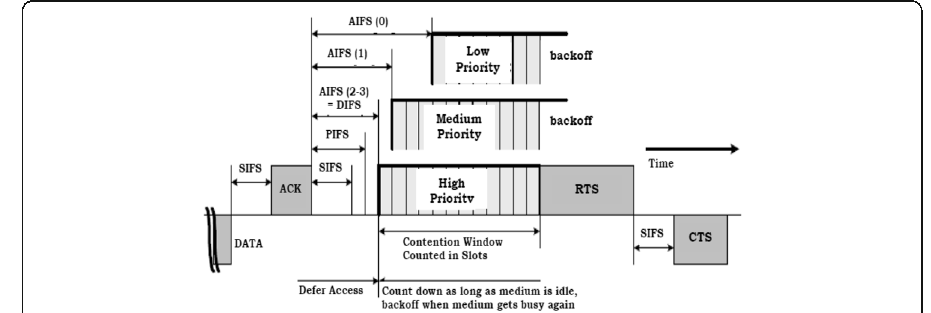
Fig. 3 IEEE 802.11e: EDCA time